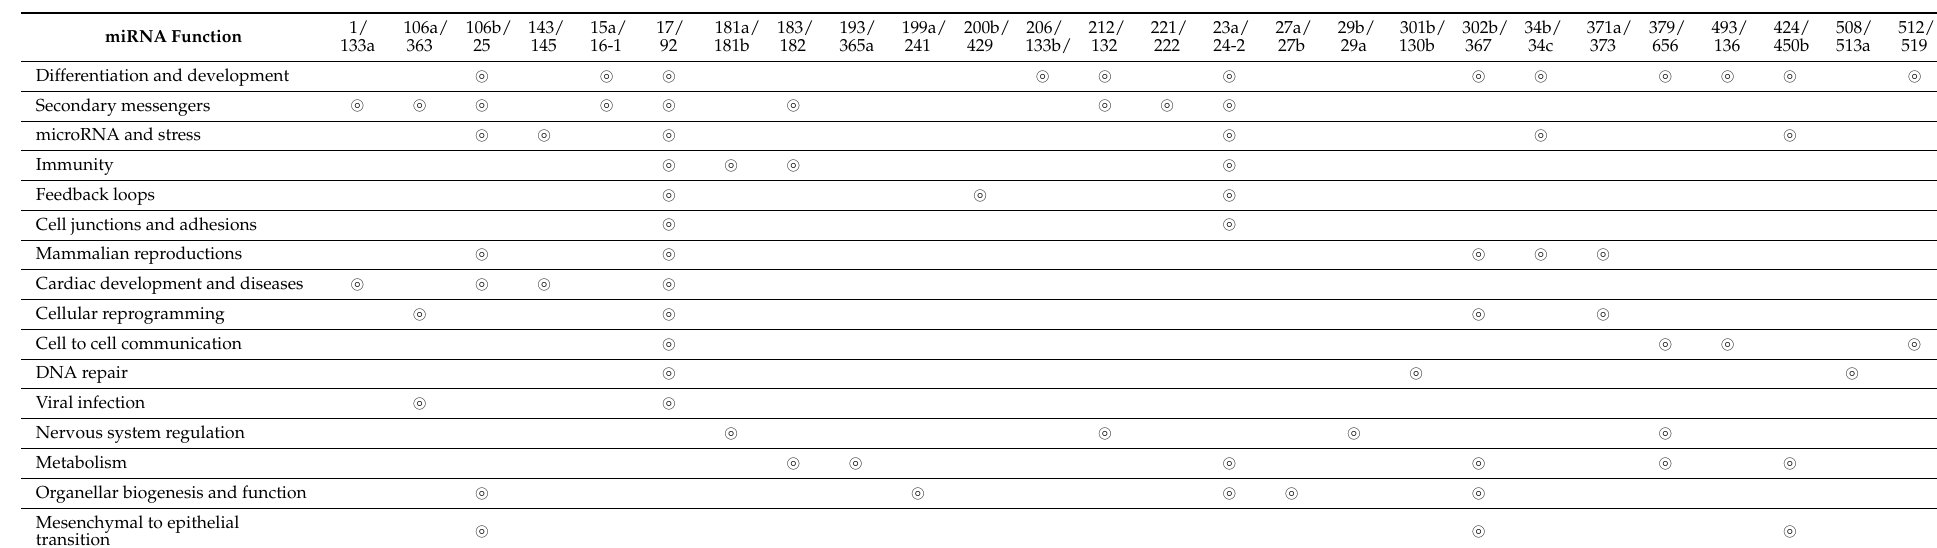
Table 1. The physiological functions of microRNA